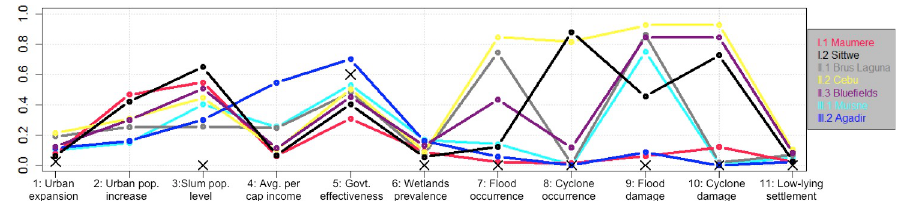
Fig 4. Vulnerability profiles and their average indicator values. The colored dots show the indicator values of the respective cluster centers. ‘X’ shows where the value is zero for each indicator. The indicator values are normalized between 0 and 1 using the minimum and maximum values for the different indicators. The colors are identical to those used in Fig 3 to depict the geographical distributions of the profiles. Each profile is given a name of a characteristic city located in it to aid the reader. Each indicator is numbered from V1 to V11 for easier comparison to Fig 5.